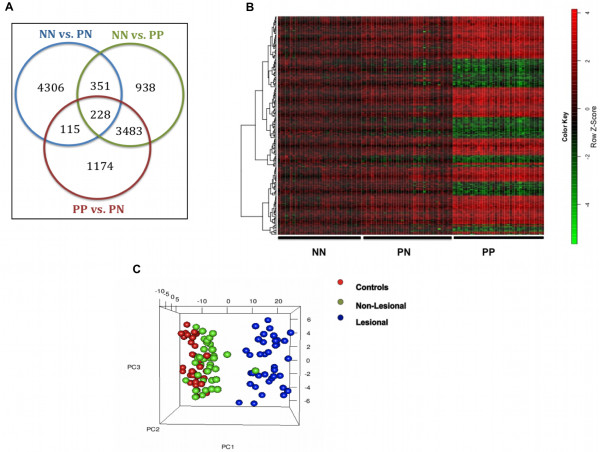
Differential gene expression in lesional (PP), non-lesional (PN) and normal (NN) skin tissue. Gene expression was analysed to reveal probe sets that were differentially expressed between pairwise comparisons of PP, PN and NN tissue groups. (A) The Venn diagram shows the number of probe sets identified in each of the three differential analyses performed. Probe sets common to all three pairwise comparisons were 228 (206 genes). (B) Microarray analysis of 108 skin tissue samples (in columns) for 206 genes (in rows) common to all tissue types, identified through differential expression analysis. Tissues have been grouped according to disease phenotype (normal NN, non-lesional PN and lesional PP) and heatmap colours indicate z-score of each gene expression value against the mean of corresponding normal values, (green: decreased expression, red: increased expression, inset). Similarity of gene expression vectors across all samples is represented by the dendrogram on the left. (C) Principal Component Analysis to suggest sample clustering across skin types according to gene expression patterns. Good separation of inflamed (PP) and non-inflamed (PN, NN) tissues was observed, indicating a progression from normal (red) to lesional skin (blue) through the non-lesional cases (green).